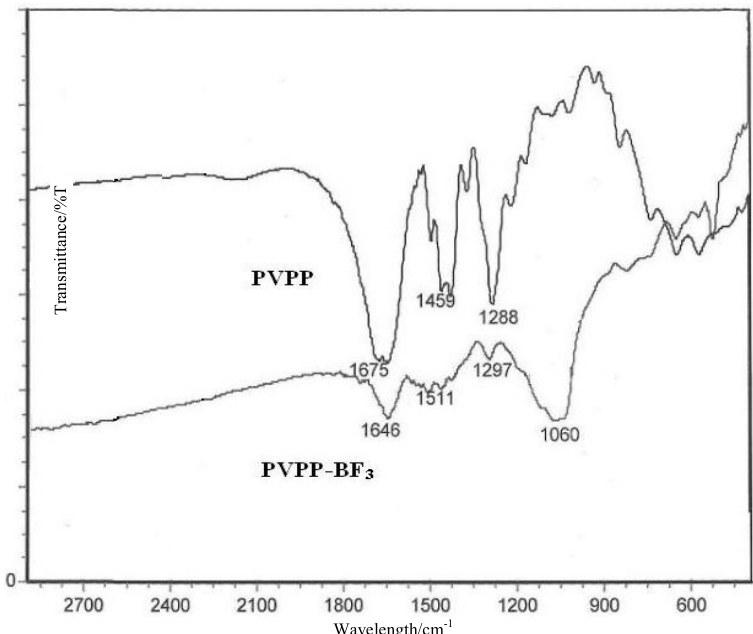
Figure 1. The Fourier transform infrared spectroscopy (FT-IR) spectrum of polyvinylpoly- pyrrolidone (PVPP) and (PVPP-BF